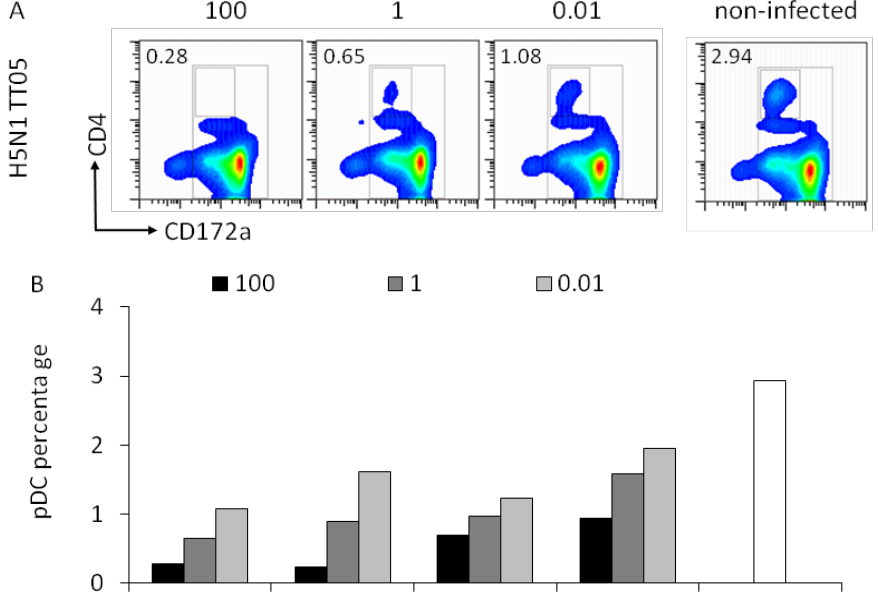
Figure 3. Relation between virus dose, pDC percentage and IFN-α response. Porcine pDC were stimulated with H5N1 TT05, H7N1 TI99, H1N1 SI76 and H1N1 NC99 (listed